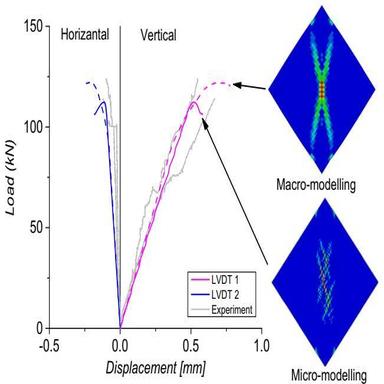
Numerical result of panel subjected to diagonal compression loading.